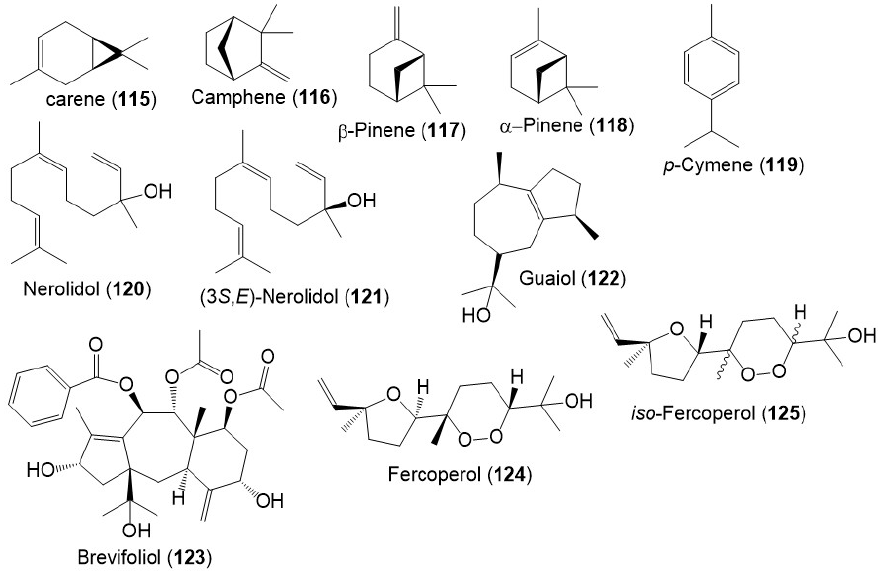
Figure 15. Structures of monoterpenes ( 115 – 119 ) and sesquiterpenes ( 120 – 125 ) reported from F. sinkiangensis